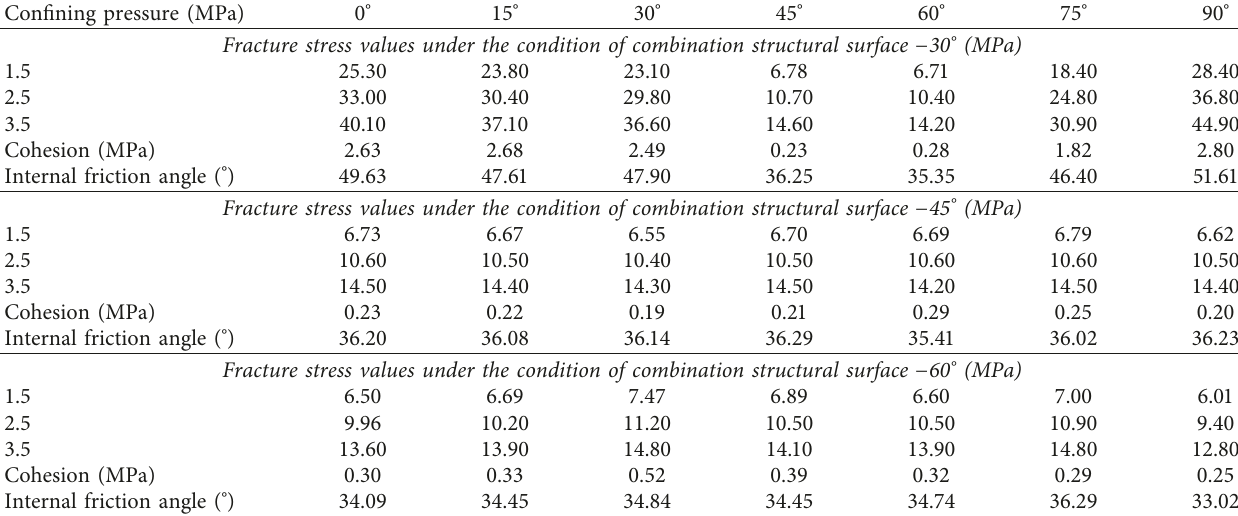
Table 2: Numerical simulation results of fracture stress values of rockmass with different structure plane combinations. Confining pressure (MPa)